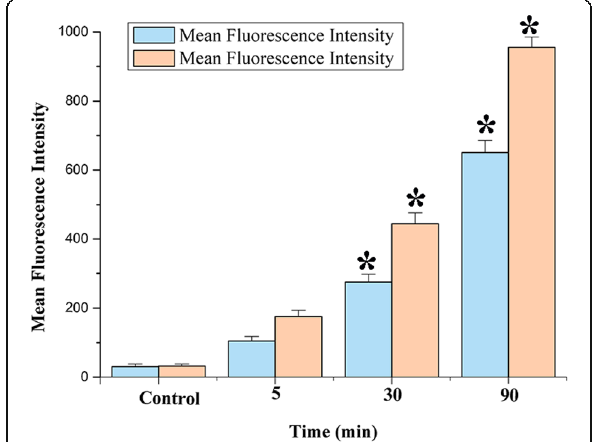
Fig. 9 Fluorescence intensity of MDA-MB-231 cells incubated with different Cur formulations (20 μ g Cur/mL). Data represented as mean±SD ( n =3). * p <0.05, one-way